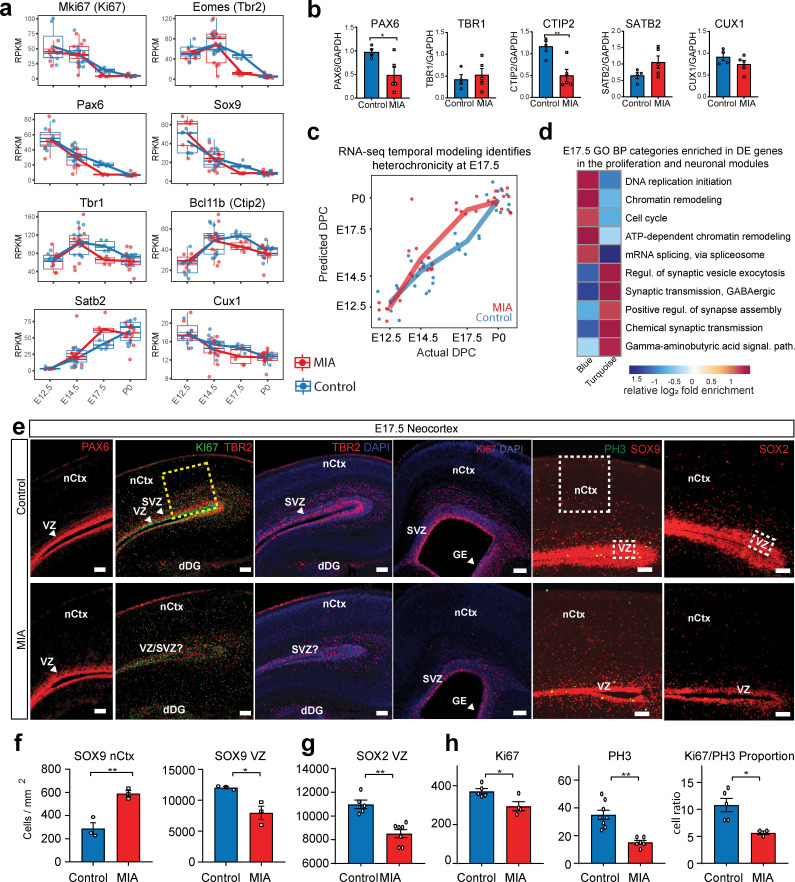
Altered cortical proliferation and lamination dynamics in fetal offspring five days after induction of MIA.(a) RPKM trajectories of proliferative and cortical lamination markers that were DE and validated at protein level. (b) Quantified protein levels from WB analysis validated DE changes at E17.5. Protein expression data are relative to GAPDH expression (n = 4 control, n = 5 MIA; PAX6 p=0.039, TBR1 p=0.615, CTIP2 p=0.0090, SATB2 p=0.1160, CUX1 p=0.2112; two tailed Student’s t-test). Individual blots are in supplementary data (Figure 4—figure supplement 1a–c,h–i). (c) Temporal modeling of the RNA-seq data suggests acceleration of the neurodevelopmental program in MIA animals at E17.5 (p =4.5e-06, Student’s t-test) and similar trend at E14.5 (p = 0.07, Student’s t-test). Actual age (X-axis) vs predicted age (Y-axis) calculated by the linear model. Control samples were used for training the model. Lines connect average values, points depict individual samples and are jittered along the X-axis. (d) GO BP categories highlighting module-specific enrichment of E17.5 DE genes in the proliferation (Blue) and neuronal (Turquoise) WGCNA modules. (e) Representative images of coronal brain sections from E17.5 saline and MIA animals show reduced progenitor populations (neural stem cells: PAX6, SOX9, SOX2, intermediate progenitors: TBR2, and general proliferative markers: Ki67, PH3) and reduced active proliferation (Ki67:PH3 ratio). Staining for all cell populations is qualitatively decreased in the cortices from MIA offspring. Yellow box indicates the region of the neocortex utilized for Ki67 and Ph3 cell counts, and white boxes indicate regions of the VZ and upper layers of the nCtx utilized for SOX9 and SOX2 cell counts reported in (f-h). Scale bars = 100 µm, (labels: nCtx: neocortex, VZ: ventricular zone, SVZ: sub-ventricular zone, dDG: developing dentate gyrus, GE: ganglionic eminence). (f) SOX9 positive cell density in the VZ as well as in the upper layers of the nCtx shows reduced and ectopic SOX9+ cells in the MIA group (n = 3 per condition, SOX9 VZ *p=0.0198, SOX9 nCtx **p=0.0058, two tailed Student’s t-test) (g) SOX2 positive cell density counts show a specific reduction in the VZ zone in the MIA group (n = 5 control group, n = 7 MIA group, SOX2 VZ **p=0.0006). (h) Ki67 and PH3 cell density quantification along the entire length of the VZ confirms this reduction in proliferative cells in MIA samples (Ki67 n = 5 control group, n = 4 MIA group, Ki67 *p=0.0198; PH3 n = 8 control group, n = 6 MIA group, PH3 **p=0.0003, two tailed Student’s t-test) as well as a reduction in the Ki67/PH3 ratio (n = 5 control group, n = 3 MIA group, *p=0.0005 Chi-Squared).